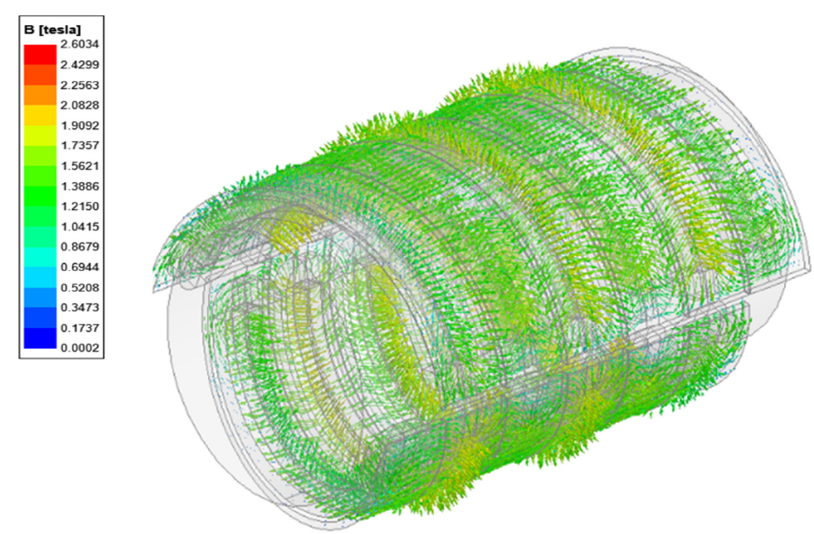
Figure 3. The 3D vector magnetic field distribution of the proposed EMLS.